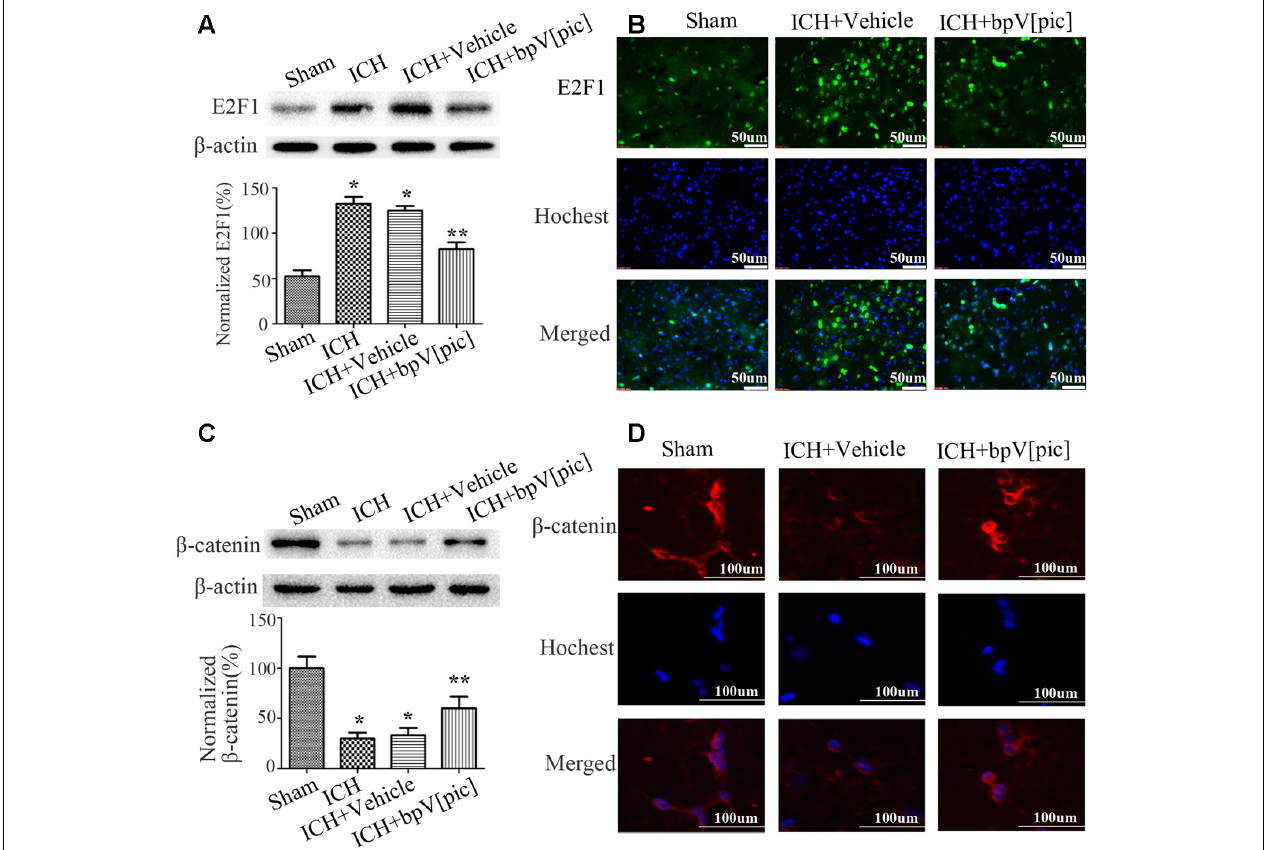
FIGURE 2 | BpV[pic] reversed the changes of E2F1 and β -catenin after rat experimental intracerebral hemorrhage (ICH). (A,B) Western bolt or immunofluorescence analysis of E2F1 expression after bpV[pic] treatment at a dose of 0.2 mg/kg 0.5 h after ICH in rats. (C,D) Western blot or immunofluorescence analysis of β -catenin expression after bpV[pic] treatment at a dose of 0.2 mg/kg 0.5 h after ICH in rats ( ∗ p < 0.05 compared to Sham, ∗∗ p < 0.05 compared to ICH+Vehicle; one-way ANOVA test, followed by Bonferroni post hoc test, N = 8).